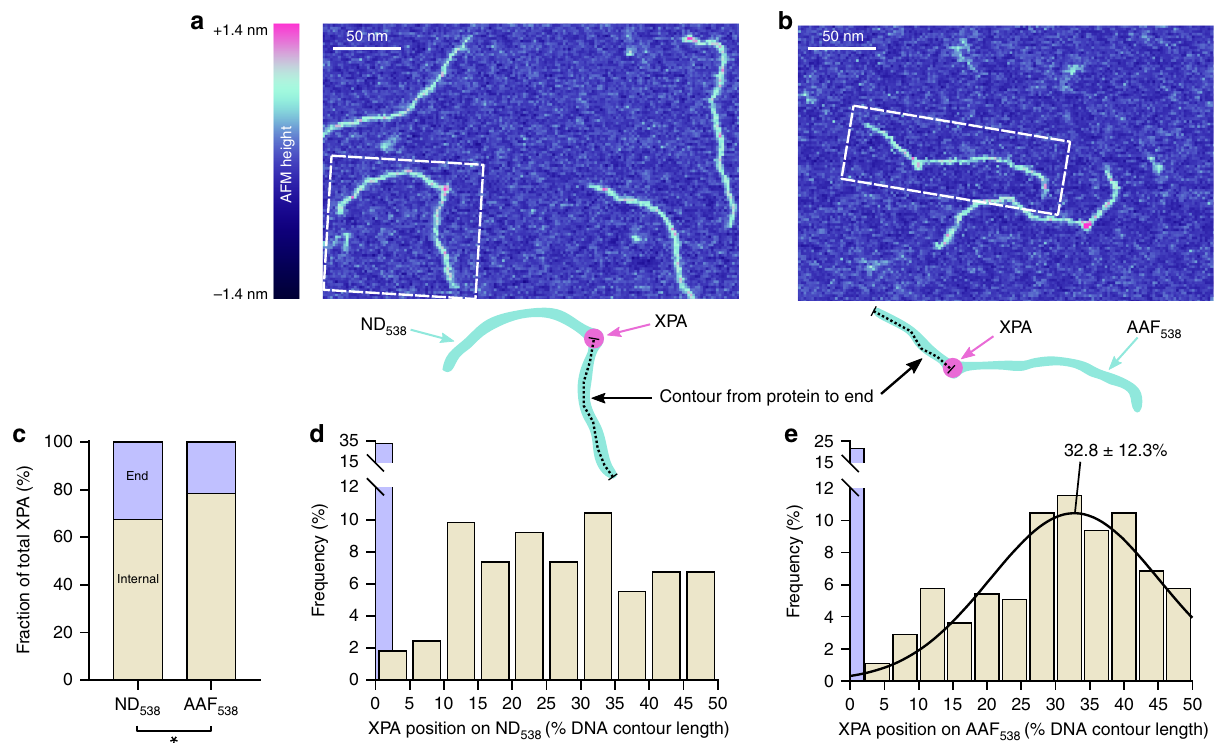
Fig. 1 XPA binds speci fi cally to a dG-C8-AAF lesion. a, b Representative AFM image of XPA bound to a non-damaged 538 bp DNA substrate ( a , ND 538 ) or a 538 bp DNA with a single dG-C8-AAF lesion at 30% from one end ( b , AAF 538 ). The dashed white line indicates the example in the cartoon below. Binding position was measured between the center of the protein to the closest DNA end as a percentage of total DNA contour length. c Percentage of XPA bound to DNA at ends (lavender) or internally (tan) on ND 538 ( n = 163 particles) and AAF 538 ( n = 277 particles). * p = 0.0118 by χ 2 test. d Histogram showing the distribution of internally bound XPA ( n = 110 particles) position on ND 538 . End-binders are shown in lavender. e Histogram and Gaussian fi tting of internally bound XPA ( n = 217 particles) positions on AAF fi t). Gaussian is labeled 538 . End binders are shown in lavender (not included in Gaussian with mean and